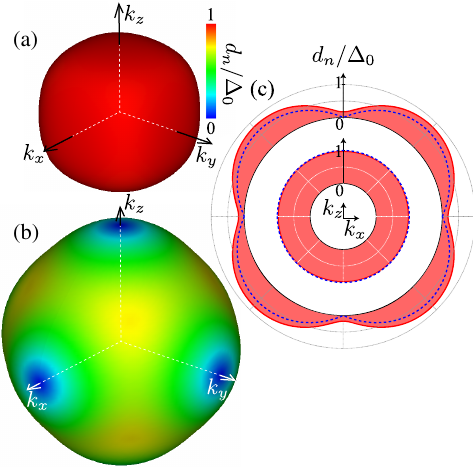
Δ j u u of A 1 representation at n ¼ h n; k j n; k i u